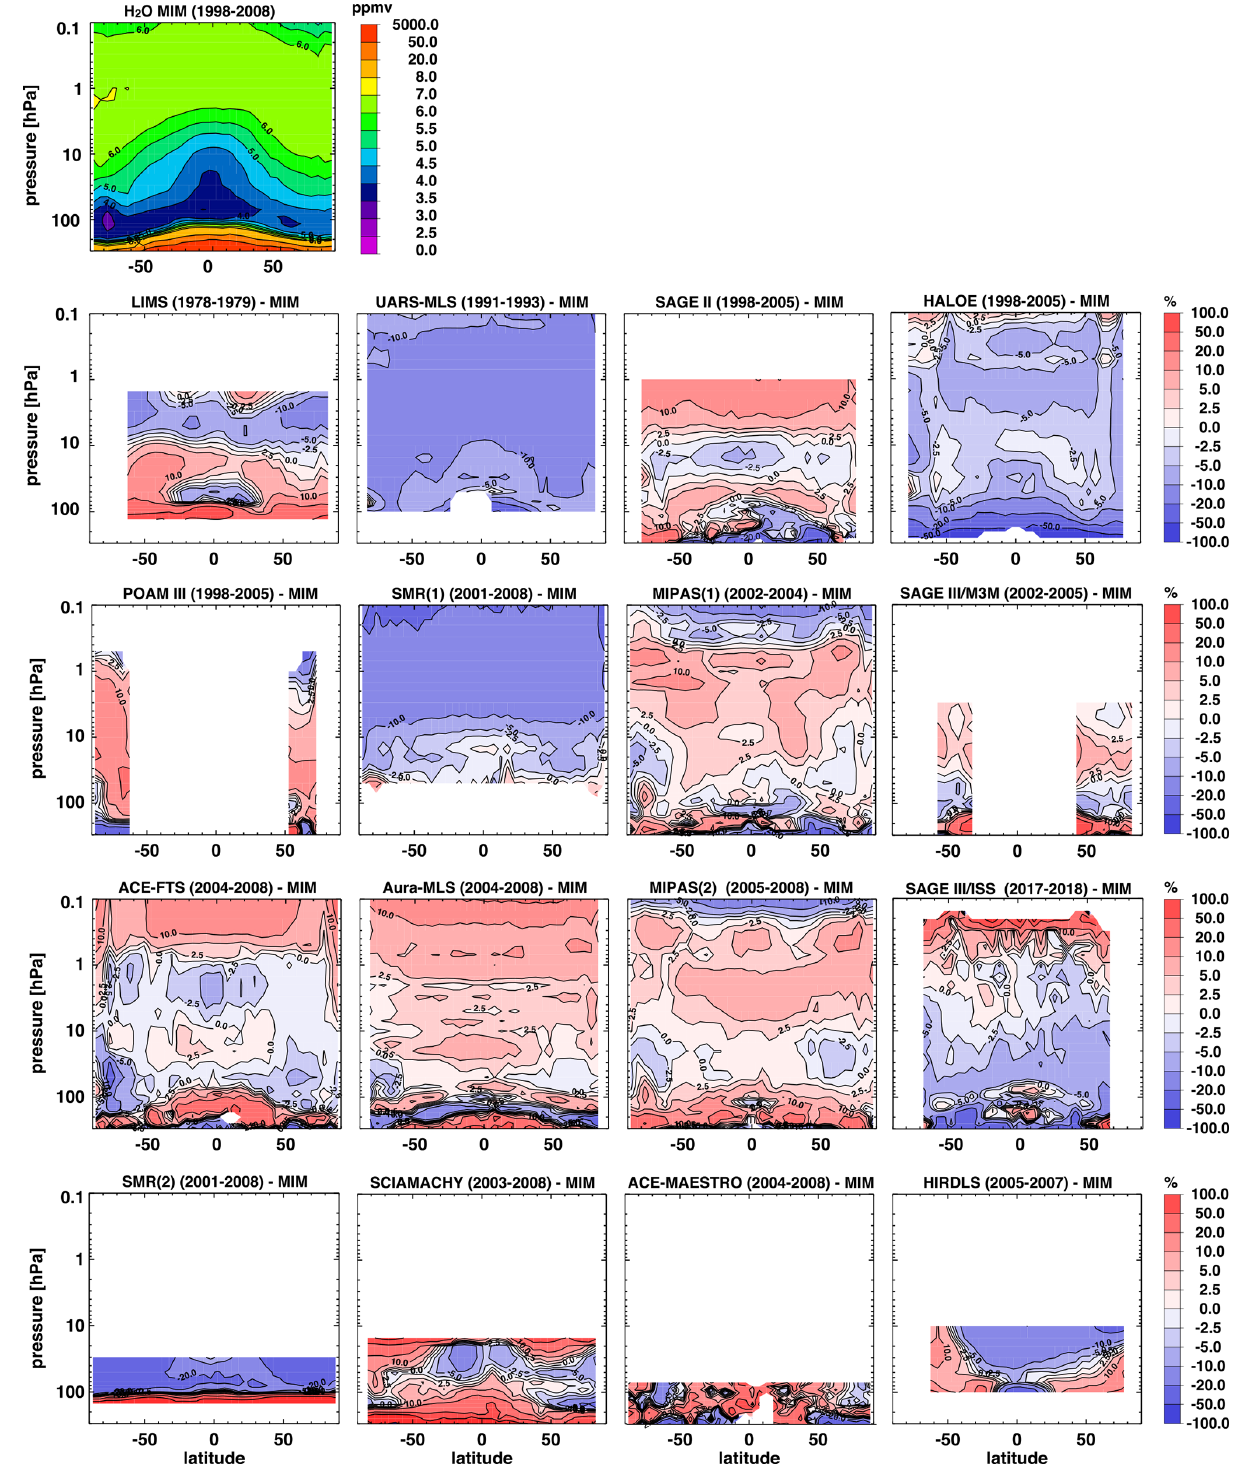
Figure 7. Cross sections of the MIM annual zonal mean water vapor for 1998–2008 and differences between the individual instruments and the MIM are shown (update from Fig. 5 in Hegglin et al., 2013). Note that LIMS, UARS-MLS, ACE-MAESTRO, SMR(2), HIRDLS, and SAGE III/ISS are not included in the calculation of the MIM to allow for a more direct comparison with Hegglin et al. (2013). Note that while none of the instruments cover the full time period, detailed evaluations of shorter time periods (e.g., 2005–2010) give very similar